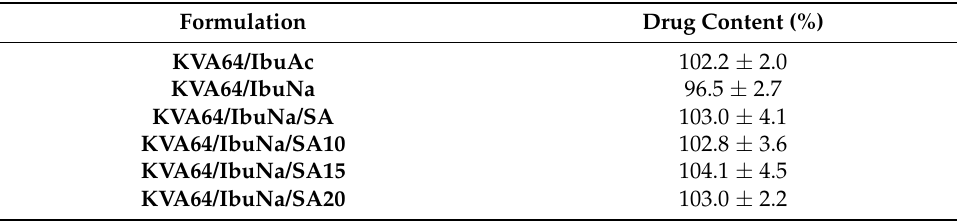
Table 5. Drug content of the different SOFs printed with